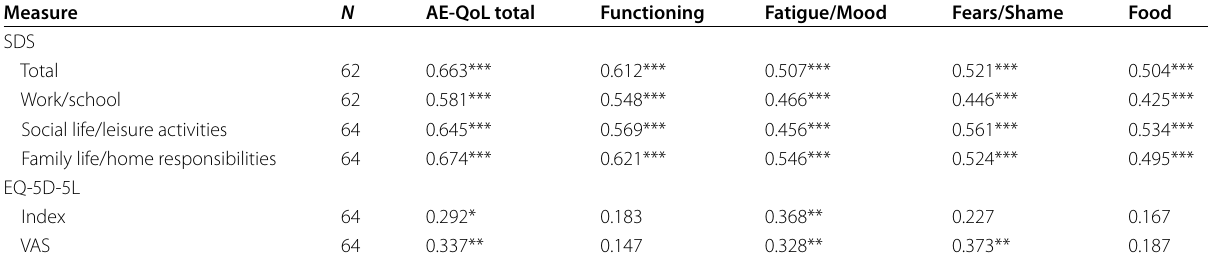
Table 5 Convergent and divergent validity correlations a at baseline between the AE-QoL and SDS, EQ-5D-5L, and EQ-VAS Measure N